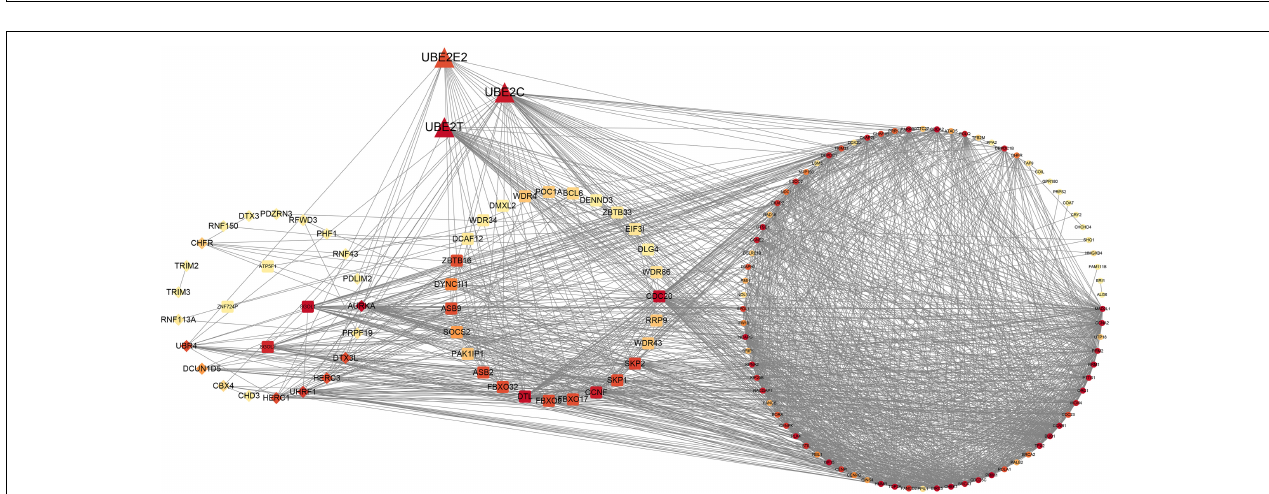
FIGURE 6 | Protein–protein interaction network of UPS and potential cell cycle-associated substrates.